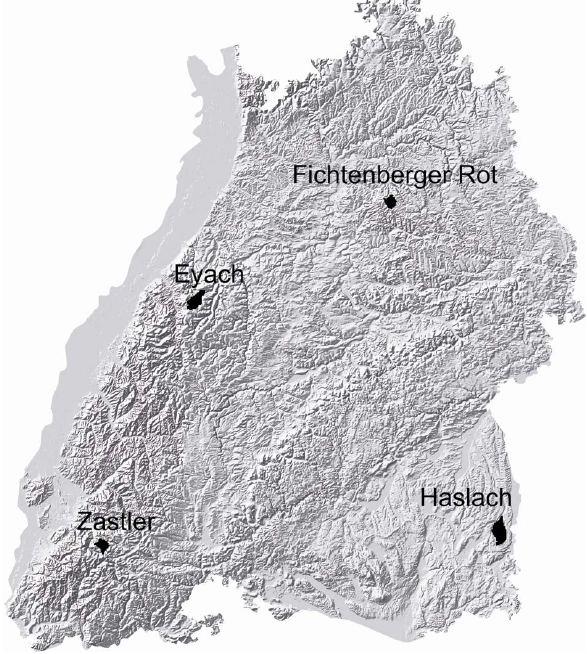
Fig. 1. Orographic map of Baden-W¨urttemberg with the location of Figure 1. Orographic map of Baden-Württemberg with the location of the four study sites. 4 the four study